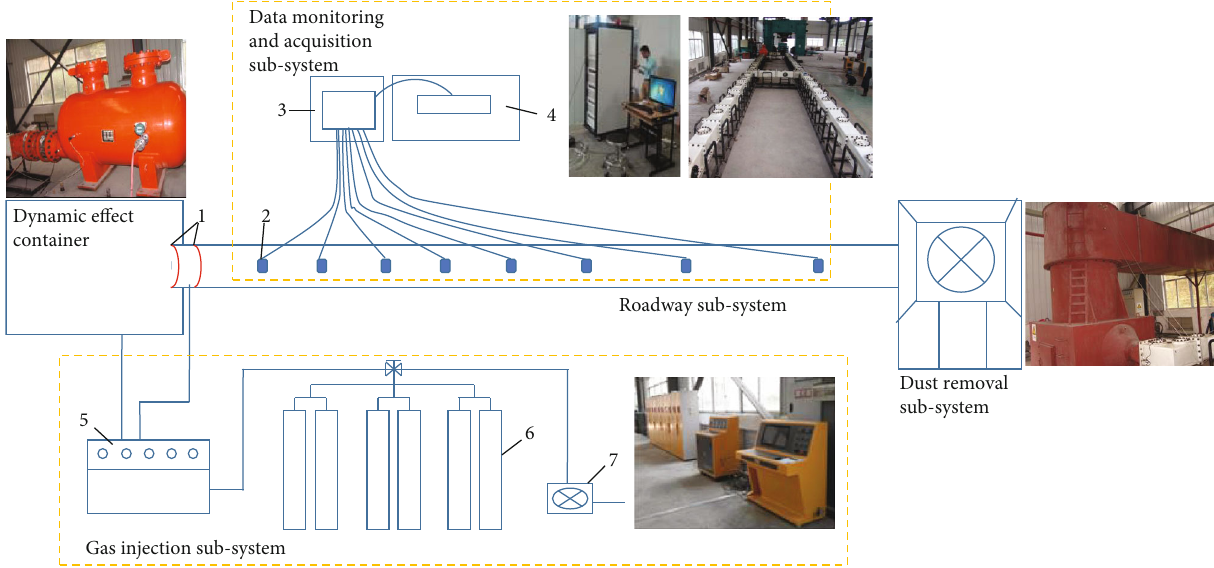
Figure 1: The simulation test device for dynamic e ff ect of coal and gas outburst: (1) bursting disc, (2) pressure\temperature\concentration sensor, (3) multifunction data acquisition controller, (4) display and operating platform, (5) controller, (6) gas cylinder, and (7) vacuum pump.